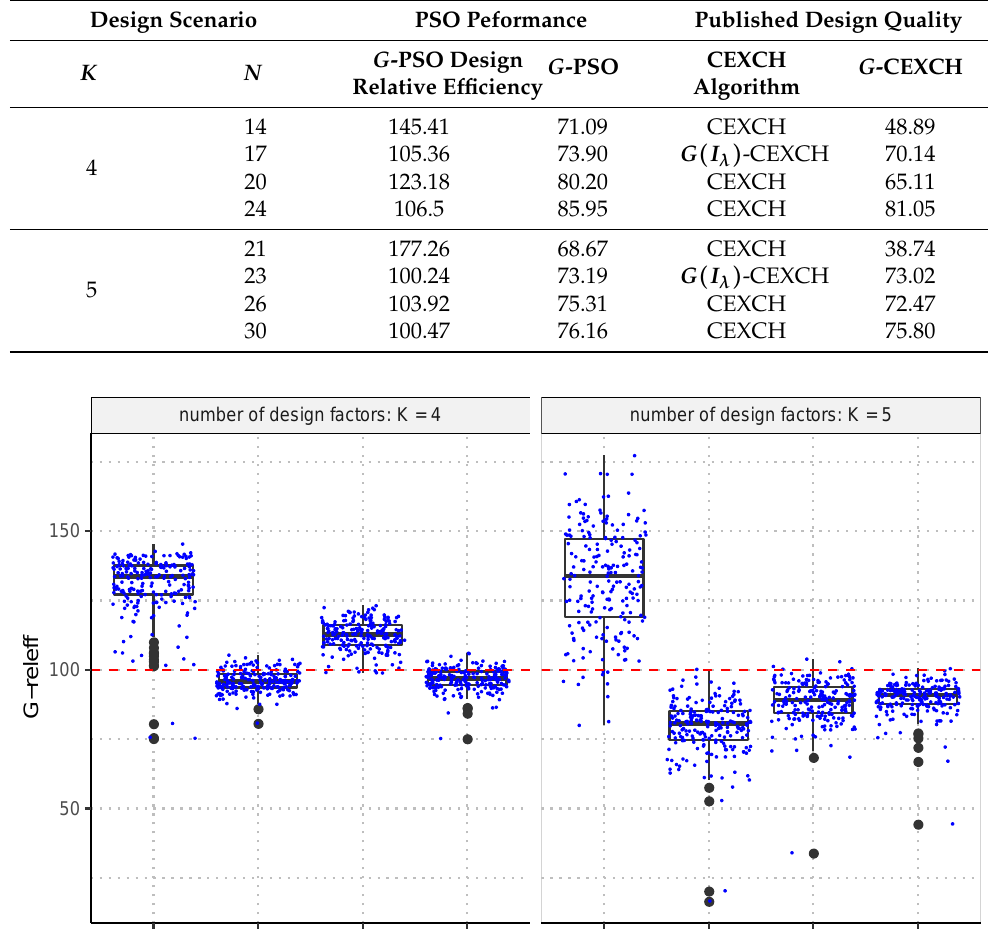
Table 4. G -efficiencies of published G -optimal designs for K = 4,5 factors. Relative efficiency of PSO generated design to published designs is shown in column 3 (over 100 means PSO generated a better design). Author [24] used the G -CEXCH while [11] used the G ( I λ ) -CEXCH.